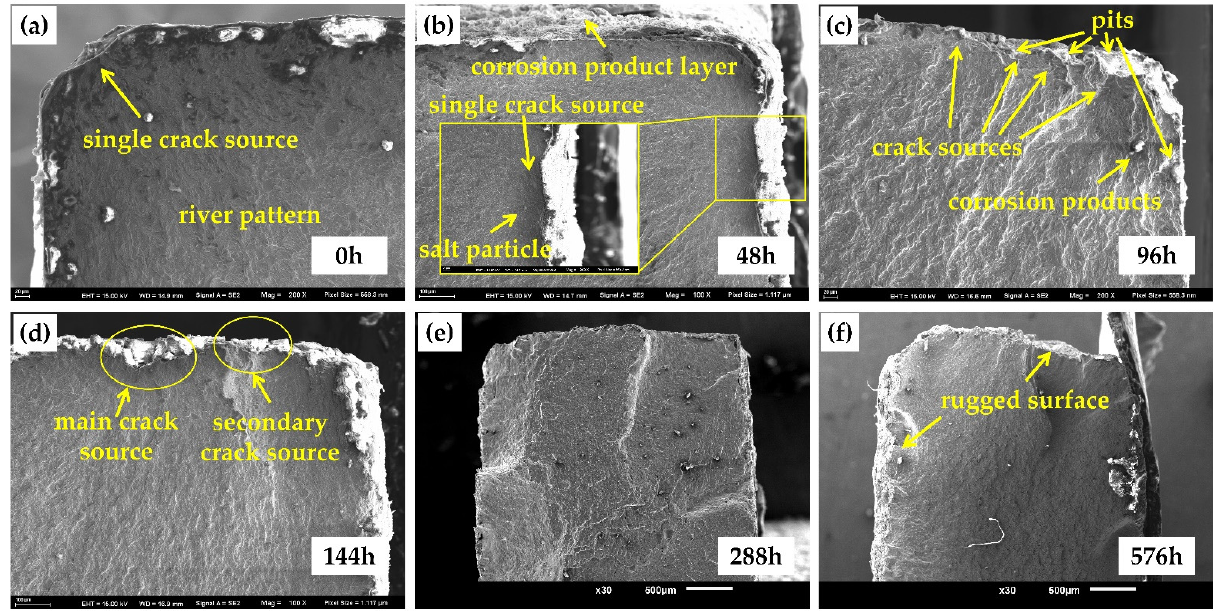
Figure 10. The microscopic morphology of the fatigue crack initiation region: ( a ) blank; ( b ) 48 h; ( c ) 96 h; ( d ) 144 h; ( e ) 288 h; ( f ) 576